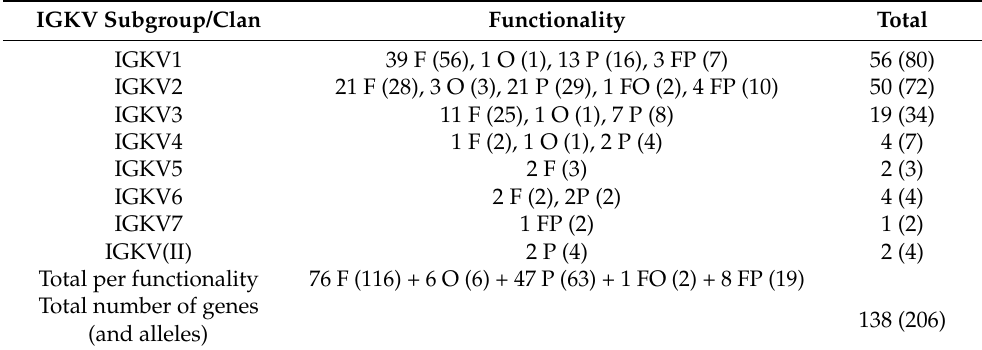
Table 12. For each IGKV subgroup, number of IGKV genes per functionality and, between parenthe- ses, number of